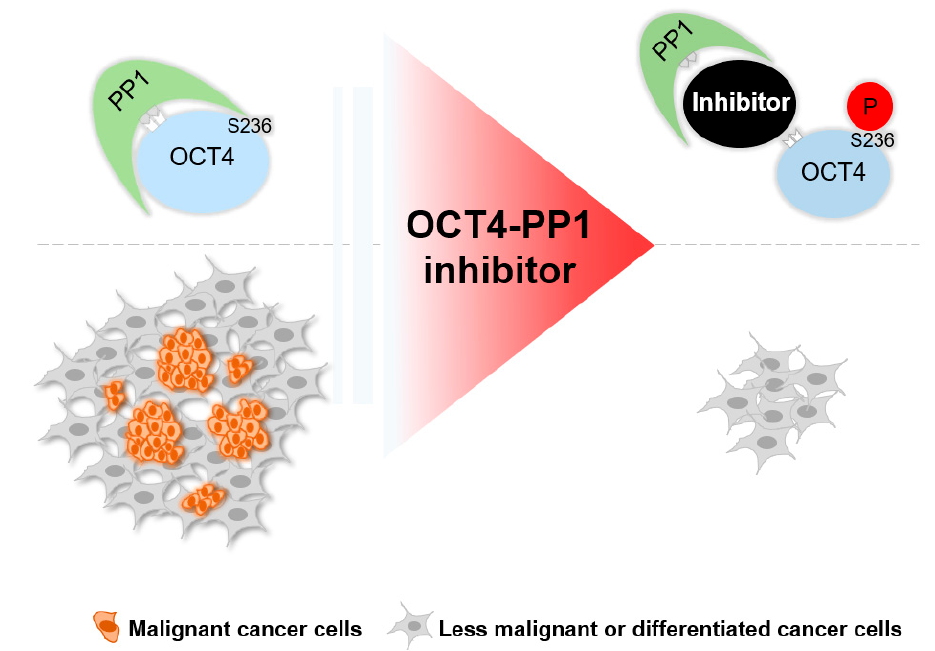
Figure 6. Potential strategy model to inhibit OCT4–PP1 interaction for cancer treatment. Inhibition of OCT4–PP1 interaction results in an increase of p-OCT4 (S236), leading to malignant cancer cell differentiation and growth retardation.